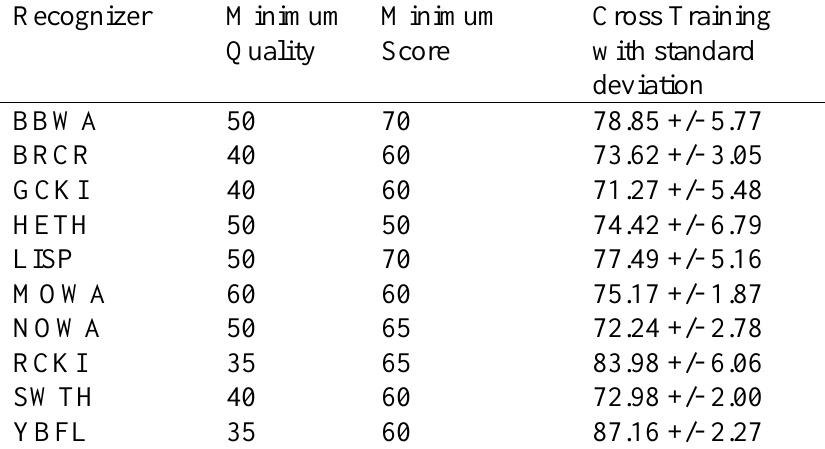
Table A1.3: Performance of song recognizers. Cross training indicates the average and standard deviation of the fit of excluded annotation identifications. Total training indicates the average and standard deviation of the fit of all the training data in the final model which includes the training